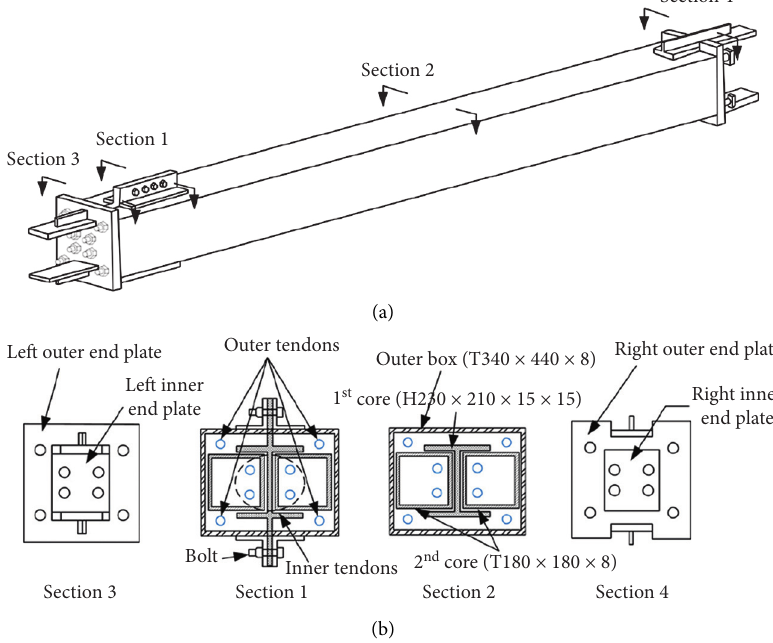
Figure 15: Details of dual-core SCB: (a) overview; (b) cross section (adapted from